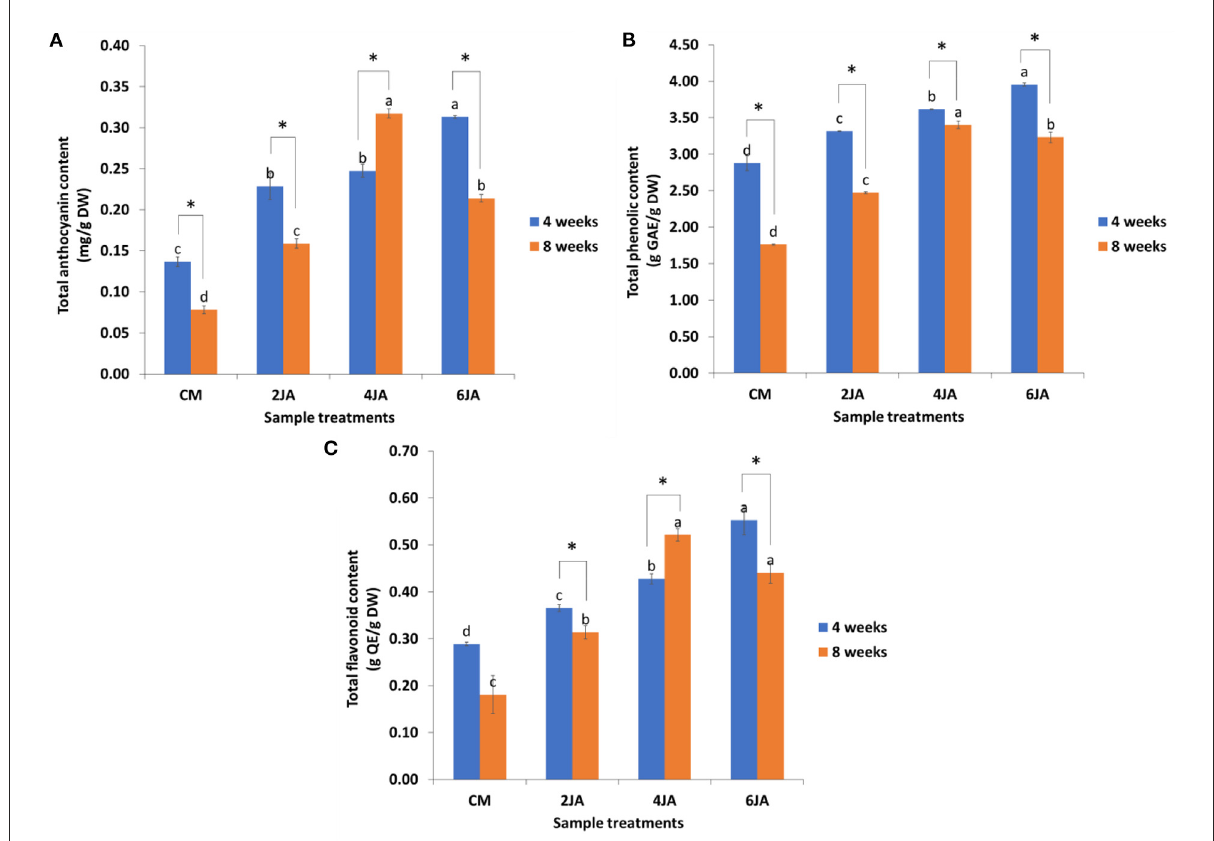
FIGURE2 Effect of different concentration of jasmonic acid on (A) total anthocyanin, (B) phenolic, and (C) flavonoid contents in 4 and 8-week-old A. indica green callus. Data expressed as mean values ± standard error (SE) of three replicates. Treatment bars denoted with different letters (subject to samples’ age) are significantly different at p ≤ 0.05 according to Duncan’s multiple range test (DMRT), while * denotes significant difference between samples’ age (at p < 0.05) according to Student’s t -test. CM , callus induction media composed of 0.6 mg/L TDZ; TDZ , thidiazuron; JA , jasmonic